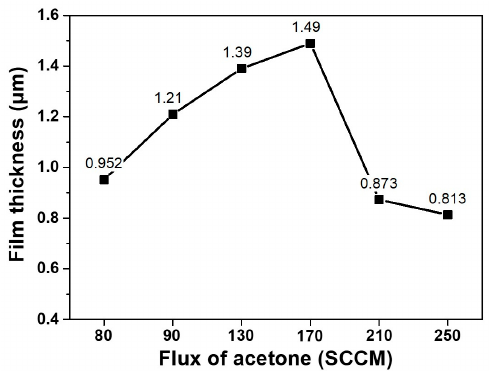
Figure 4. Thickness of the diamond films deposited at acetone fluxes of 80, 90, 130, 170, 210 and 250 sccm at 4000 Pa.